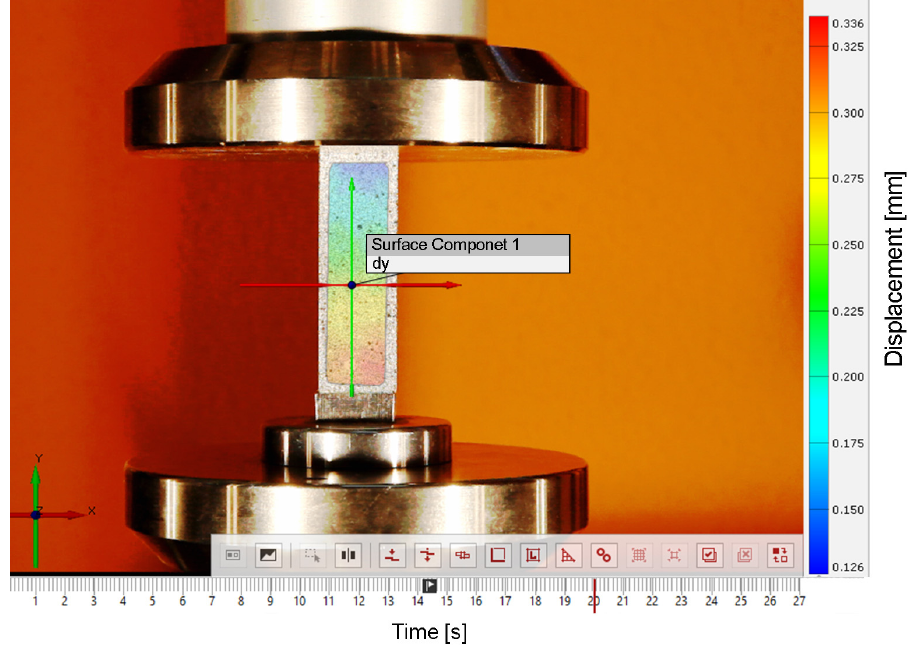
Figure 4. Study surface and color map of displacements.